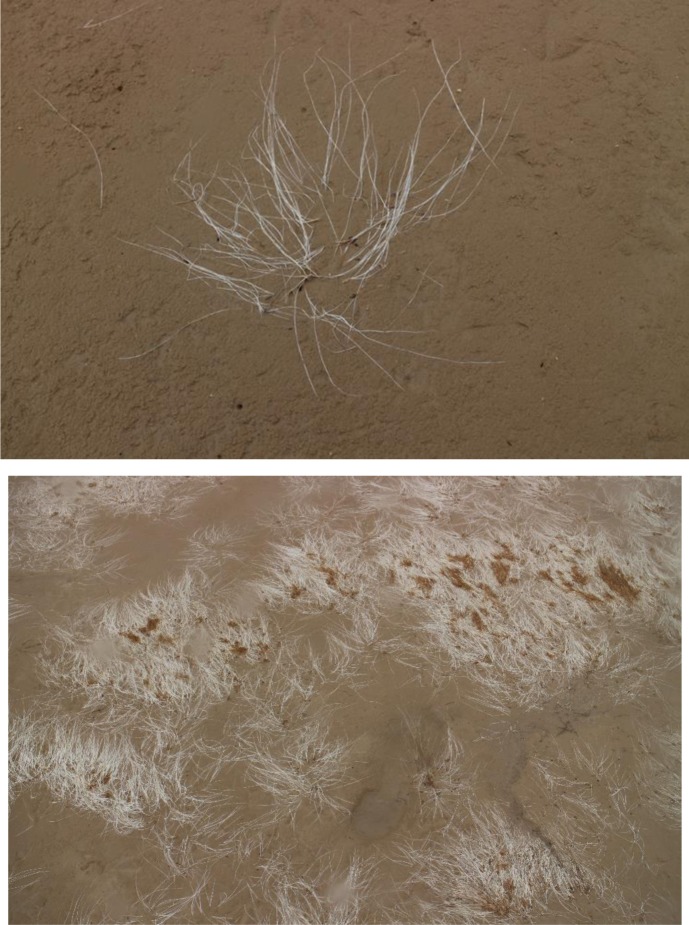
Ruppia sinensis containing seeds exposed to desiccation in the Diaokou area.